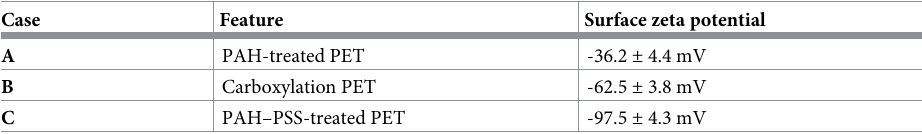
Table 1. Characteristics of the membranes tested in this